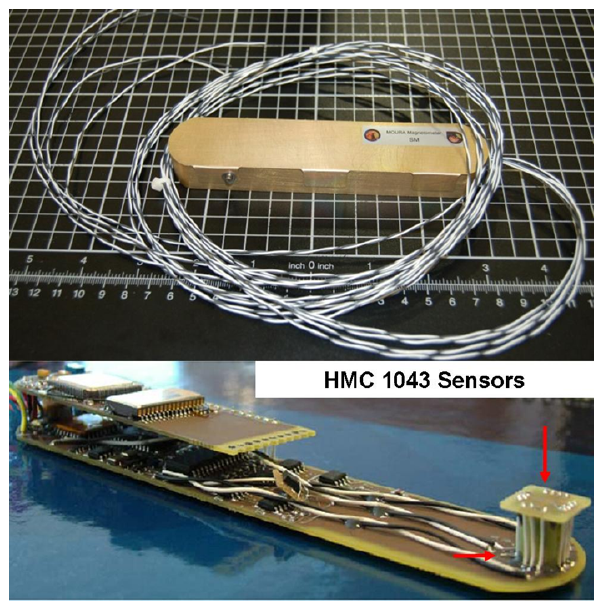
Figure 2. QM-MOURA box and detailed view of position of both HMC1043 sensors (red